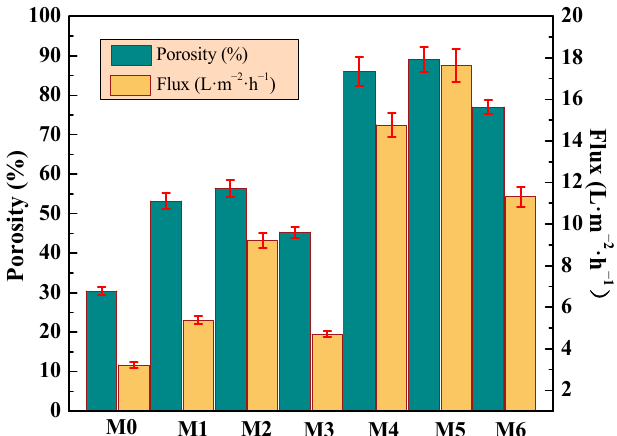
Figure 9. Porosity, and pure water flux of the membranes incorporated with different amounts of mCNTs grafting single and diblock chains and membranes with oriented or unoriented mCNTs.